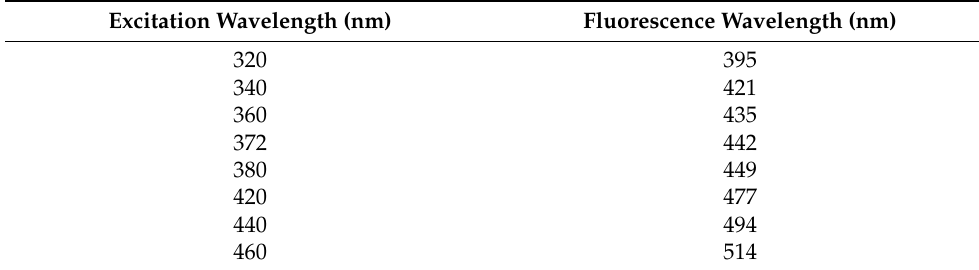
Table 2. The fluorescence wavelength at different excitation